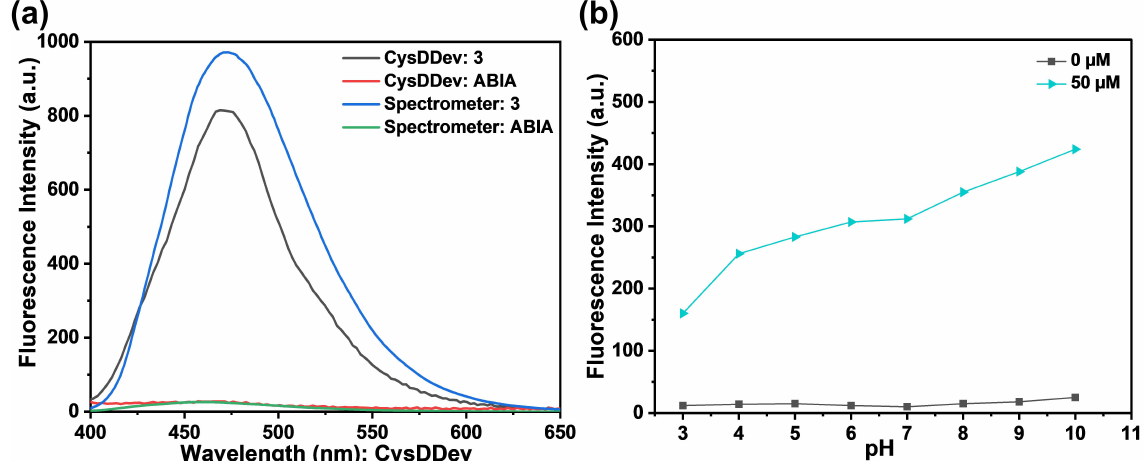
Figure 5. ( a ) Fluorescence spectra of compound 3 (10 µ M, λ ex = 370 nm) and ABIA (10 µ M, λ ex = 370 nm) recorded using CysDDev and commercial fluorescence spectrometer; ( b ) effect of pH on the detection of Cys (0, 50 µ M) in simulated human urine at various pH using ABIA and CysDDev ( λ ex = 370 nm, λ em = 455